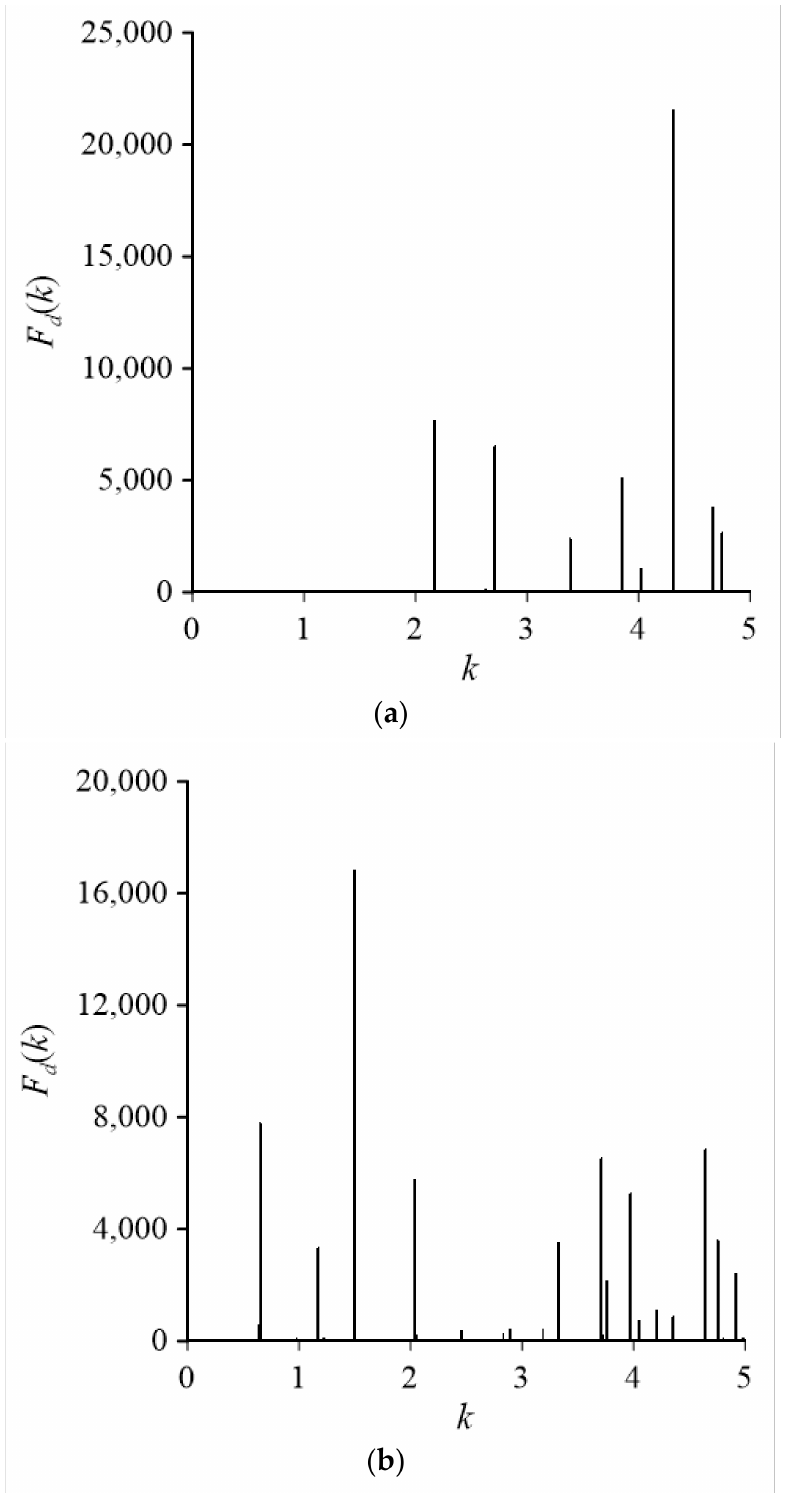
Figure 12. Resonance curves for multi-connected domain waveguide for ( a ) TM mode and ( b ) TE